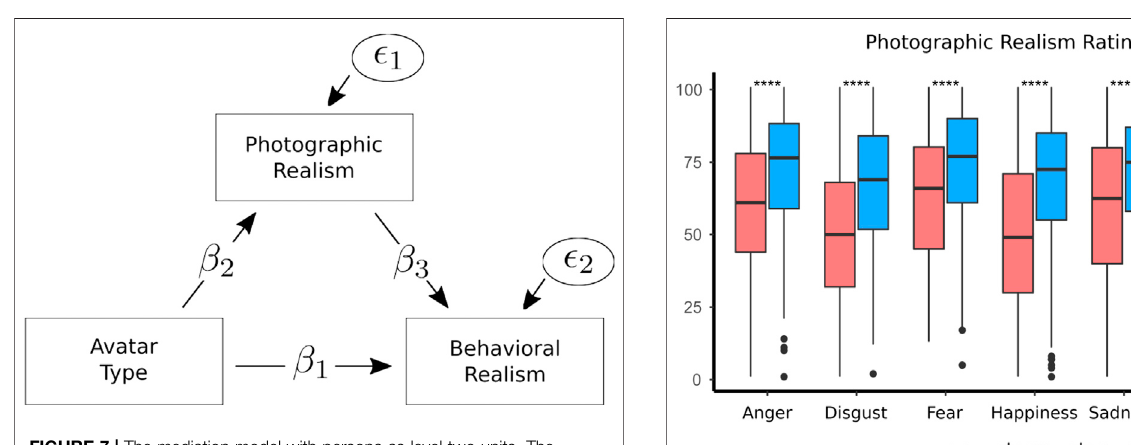
FIGURE 7 | The mediation model with persons as level two units. The LMM was estimated to study whether differences in avatar type with respect to behavioral realism are driven by differences in photographic realism. β 1 , direct effect; β